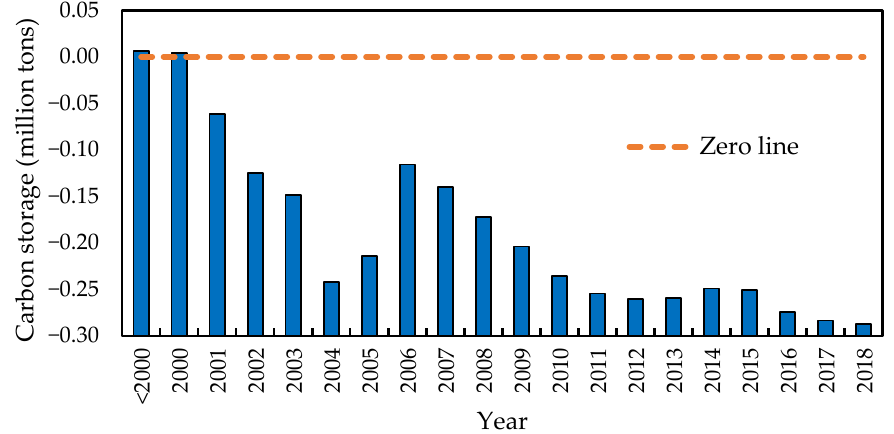
Figure 11. The cumulative differences in carbon storage between the actual and hypothetical sce- narios.